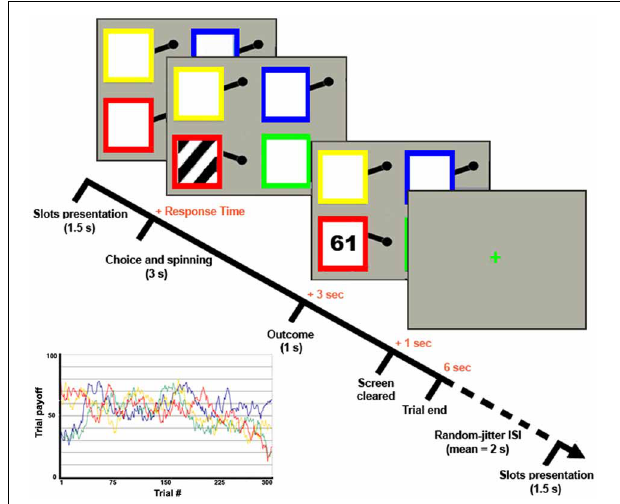
FIGURE 1 | 4-armed bandit task. Graphical representation of the 4-armed bandit task and of the slots’ payoff functions [following the task design of Daw et al.